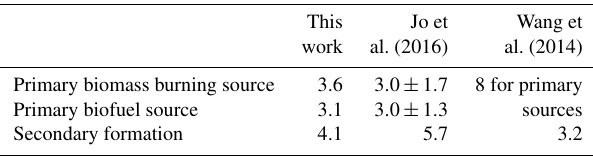
Table 1. BrC emission sources (TgCyr − 1 ) of this and previous